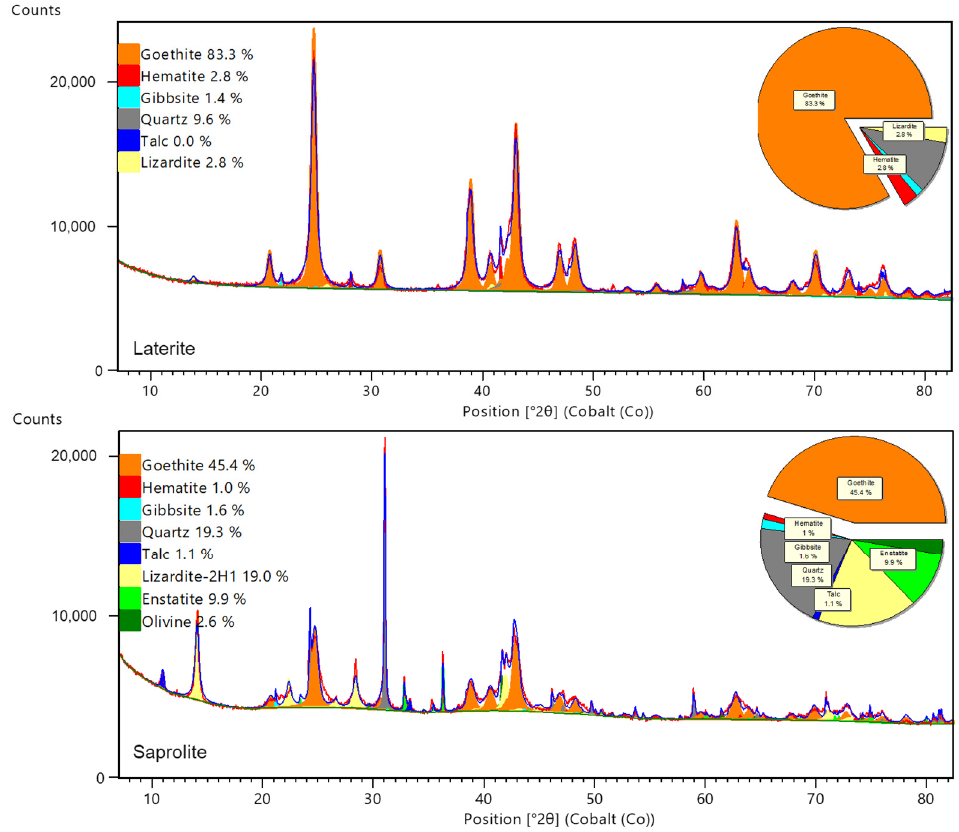
Figure 9. Example of a full-pattern Rietveld quantification of a lateritic (R wp = 3.3) and saprolitic (R wp = 4.6) ore. (R wp = 4.6)